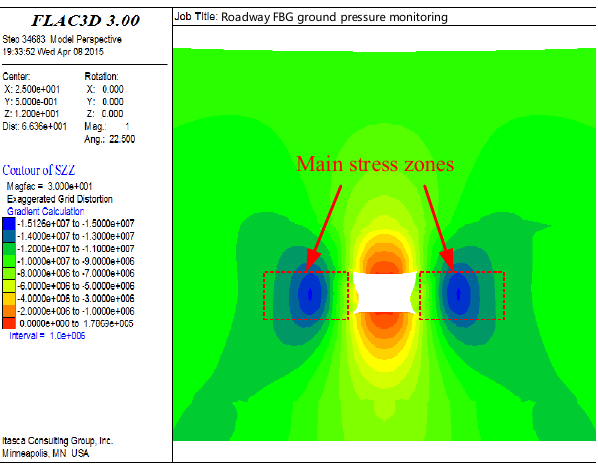
Figure 12. Stress and displacement distribution of surrounding